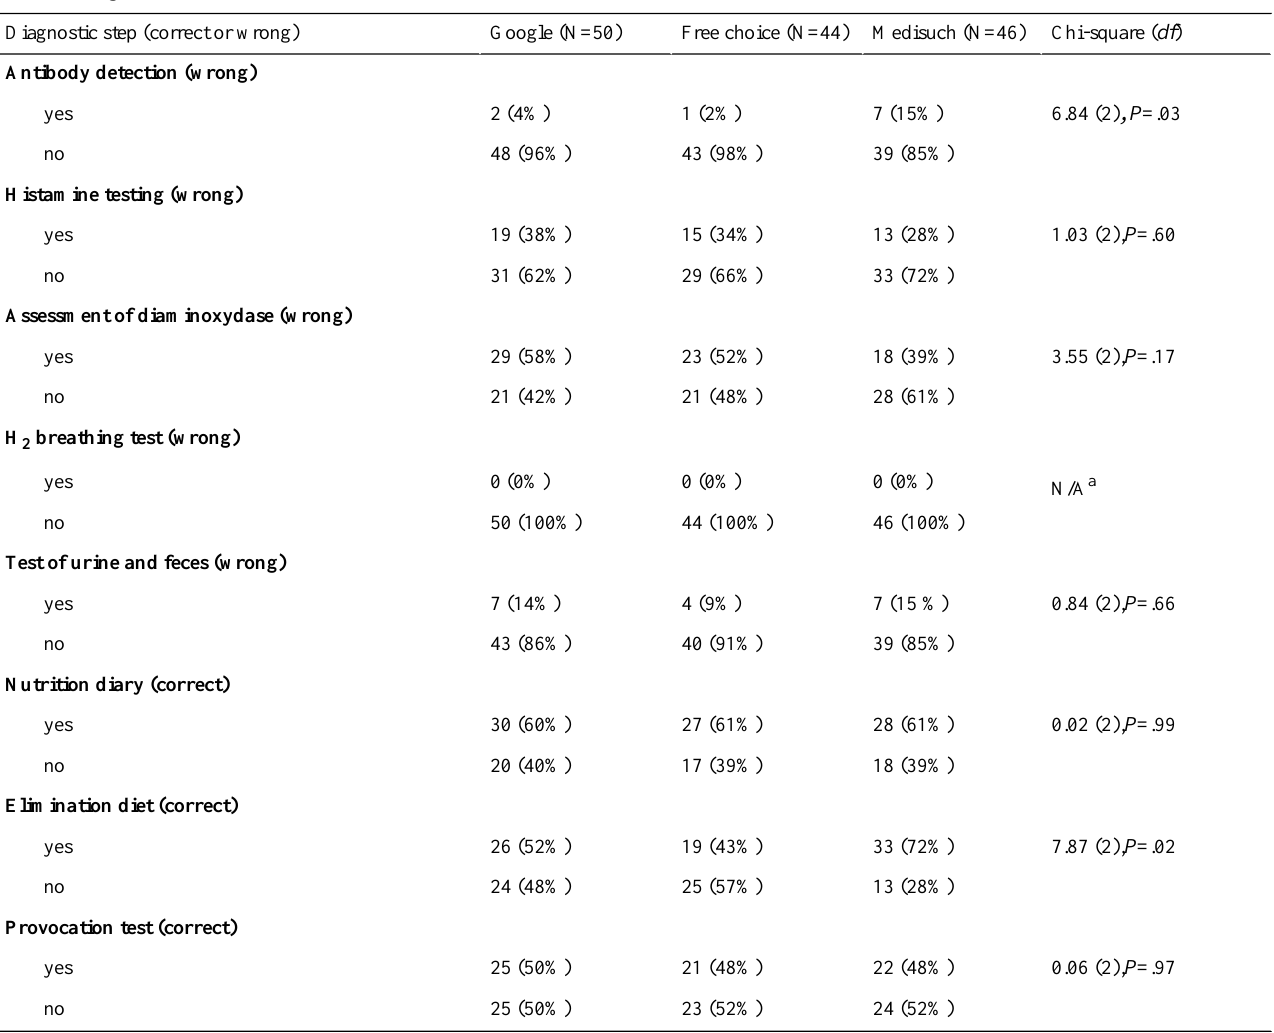
Table 1. Diagnostic decision after online